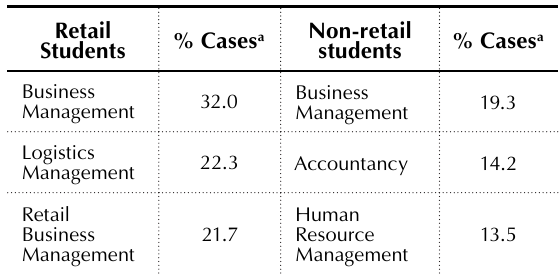
Table 3. TOP 3 consideration set of